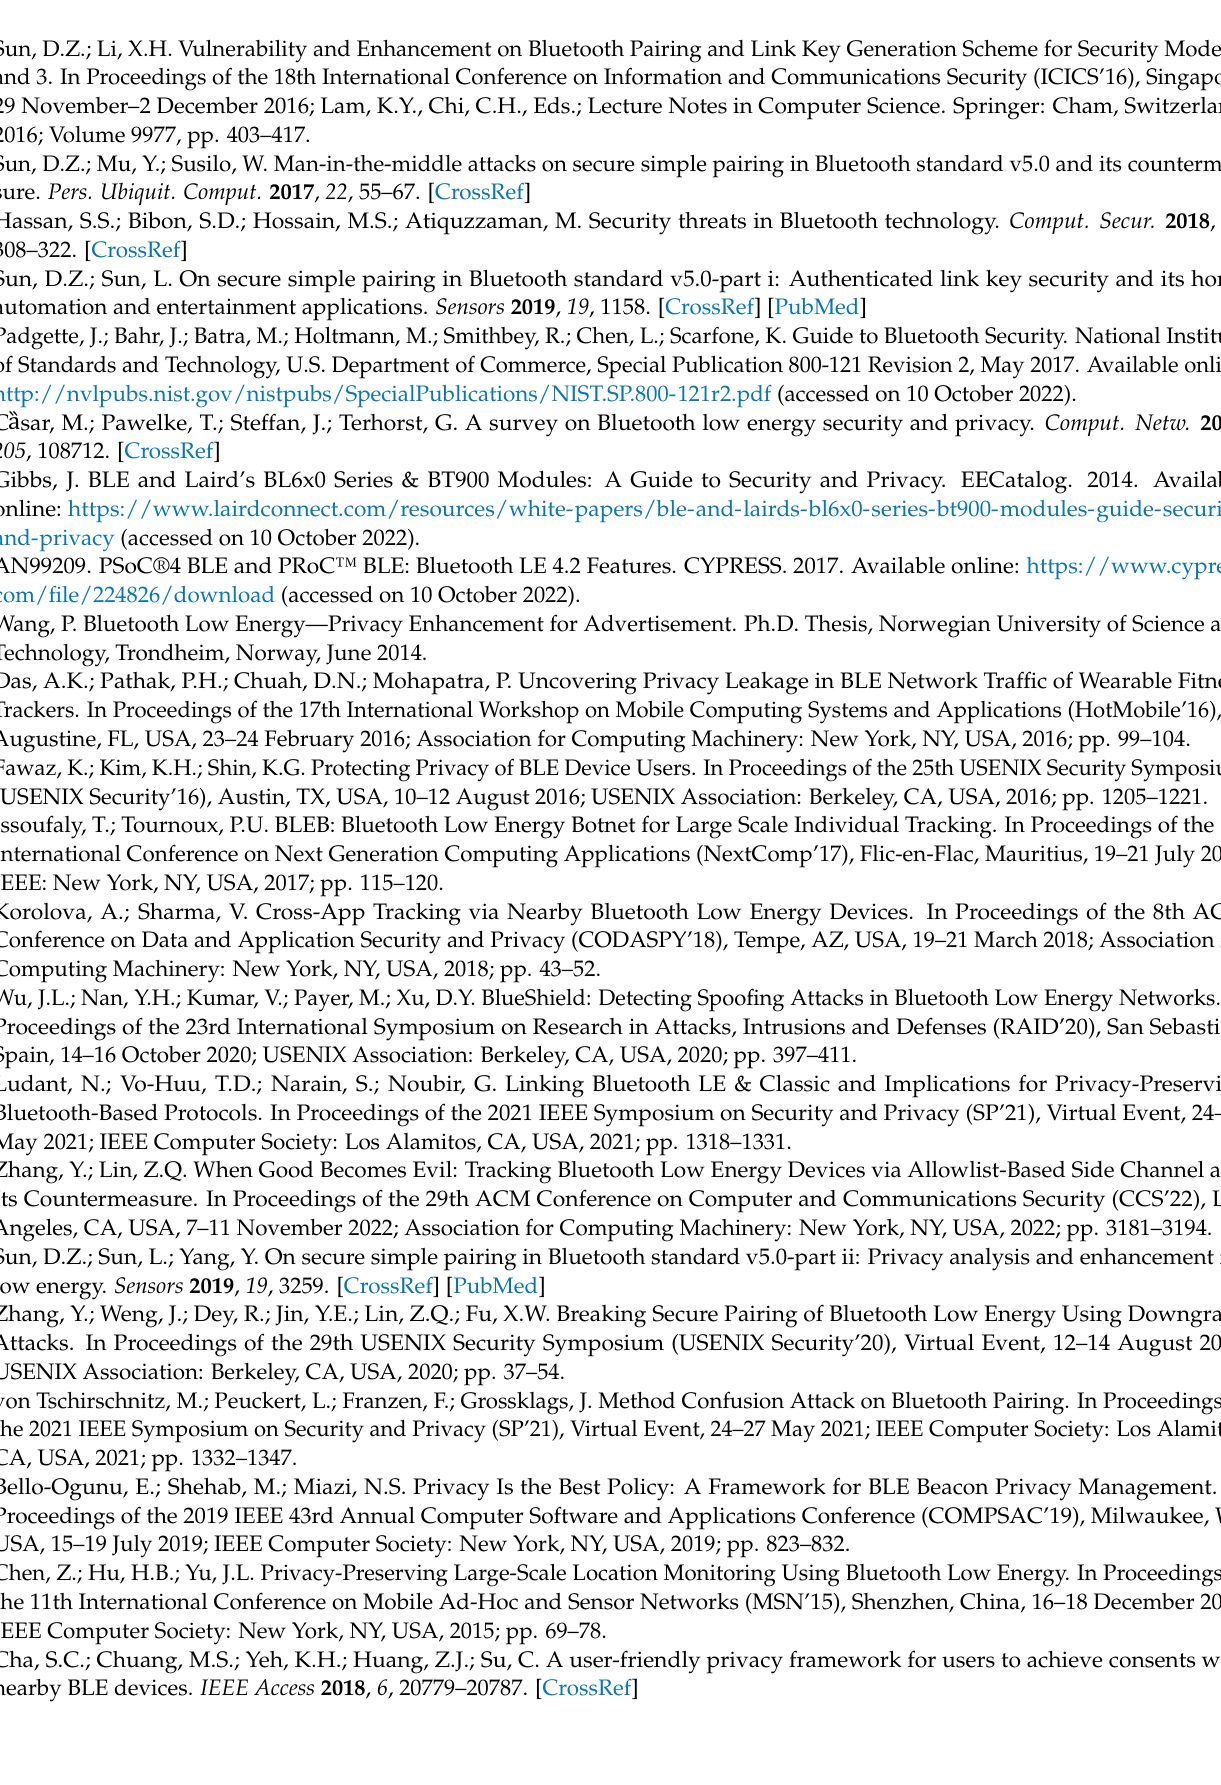
Figure 1. Privacy analysis of Bluetooth personal